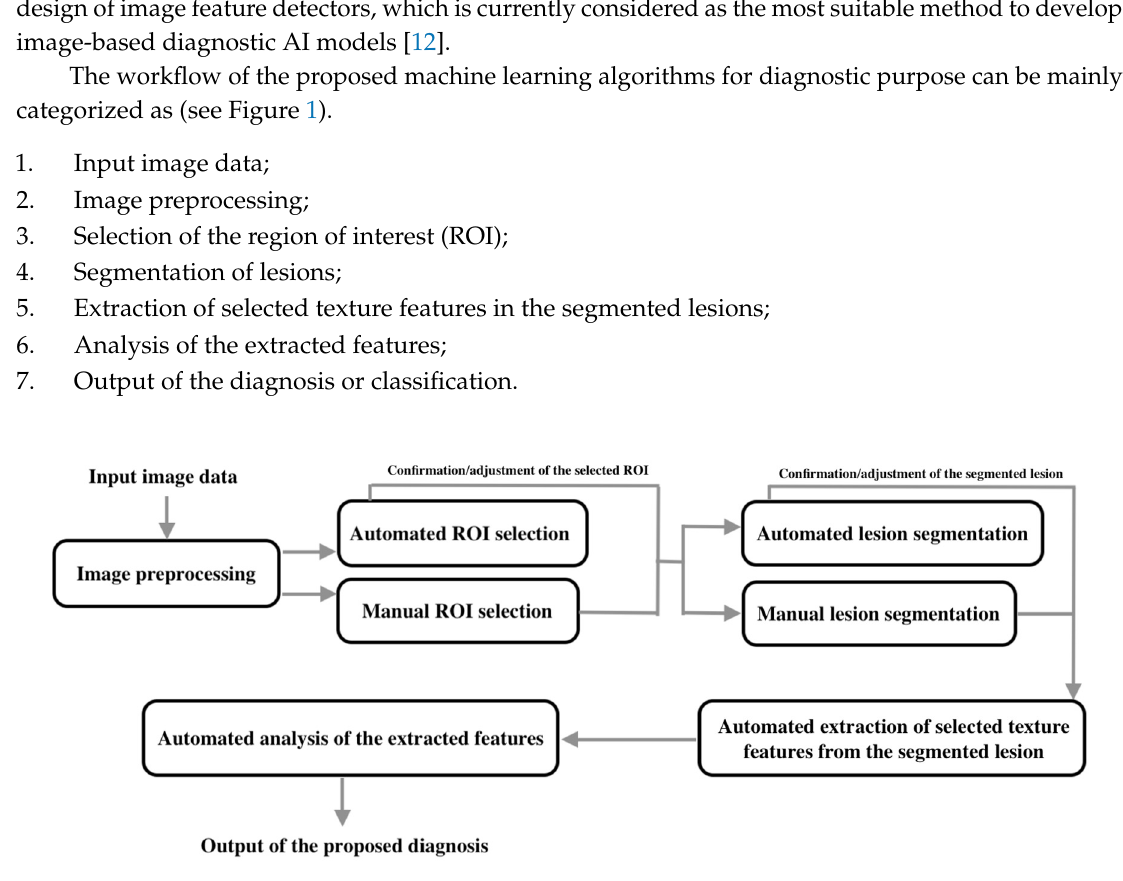
Figure 1. The workflow of the proposed machine learning algorithms for diagnostic purposes.